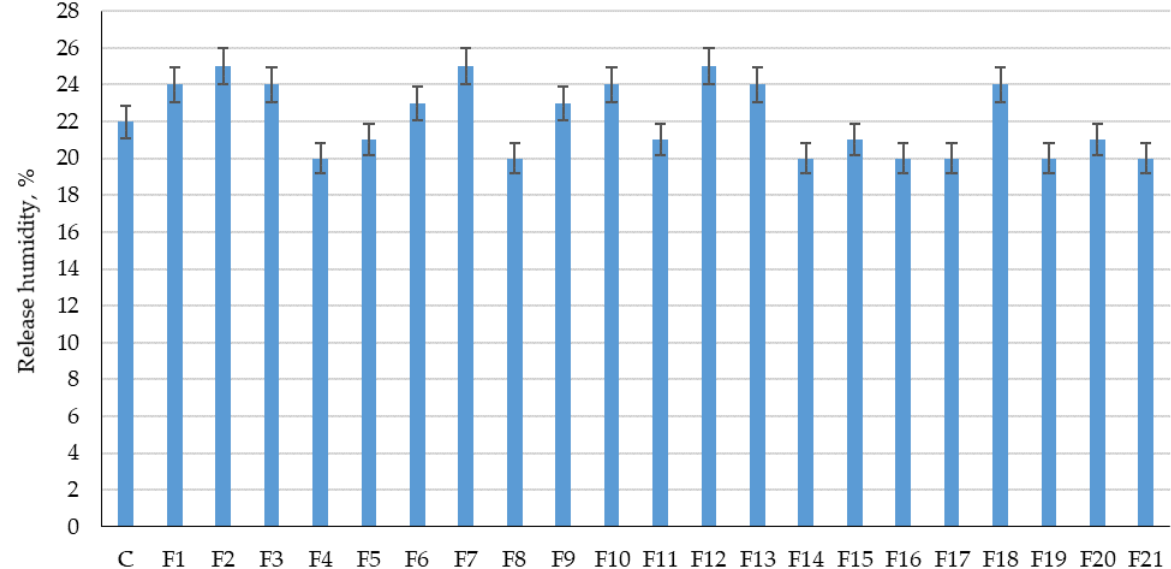
Figure 13. Results of experimental studies of the thermal conductivity of fiber foam concrete sam- ples at various dosages of microsilica introduced instead of a part of the binder and dosages of polypropylene fiber of 0%, 1%, 2%, 3%.